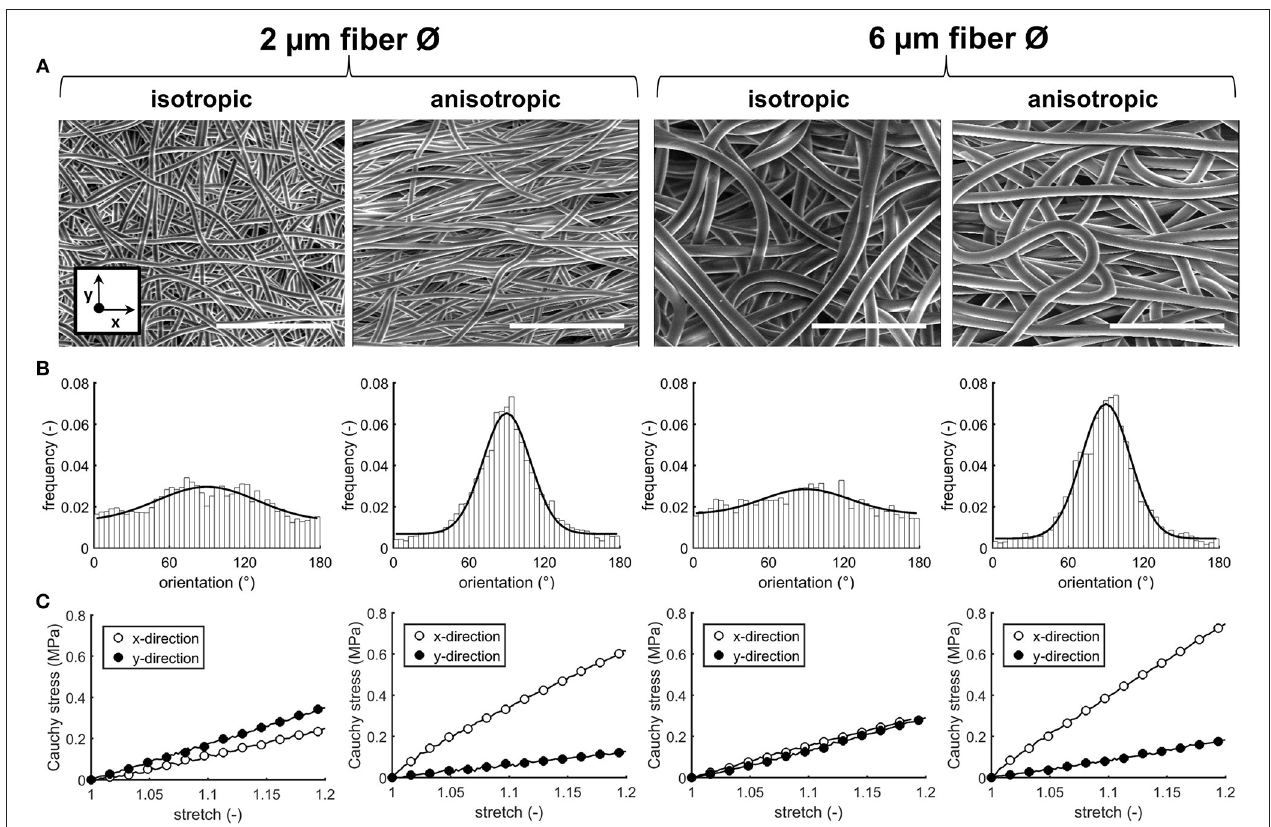
FIGURE 2 | Scaffold characteristics. SEM images of the electrospun PCL-BU scaffolds with different fiber diameter and alignment. Scale bars, 50 µ m (A) . Frequency histograms with fitted Gaussian distributions to visualize the degree of fiber alignment (90 ◦ = main axis) (B) . Average cauchy stress-stretch curves of the electrospun microarchitectures ( n = 2/group, x = circumferential direction of the electrospinning mandrel; y = axial direction of the electrospinning mandrel) (C) .